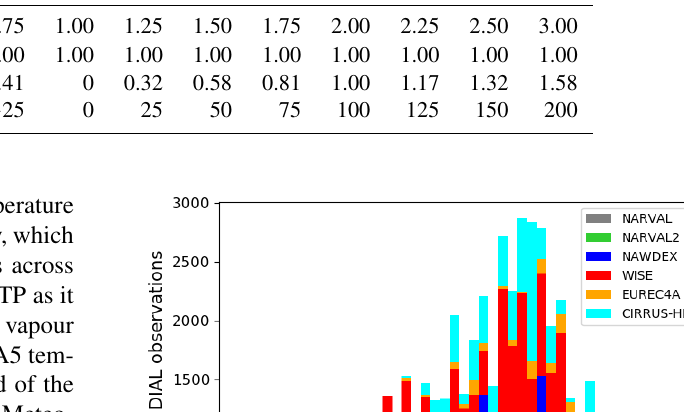
Table 2. Some example values of specific humidity and the according computed humidity bias.